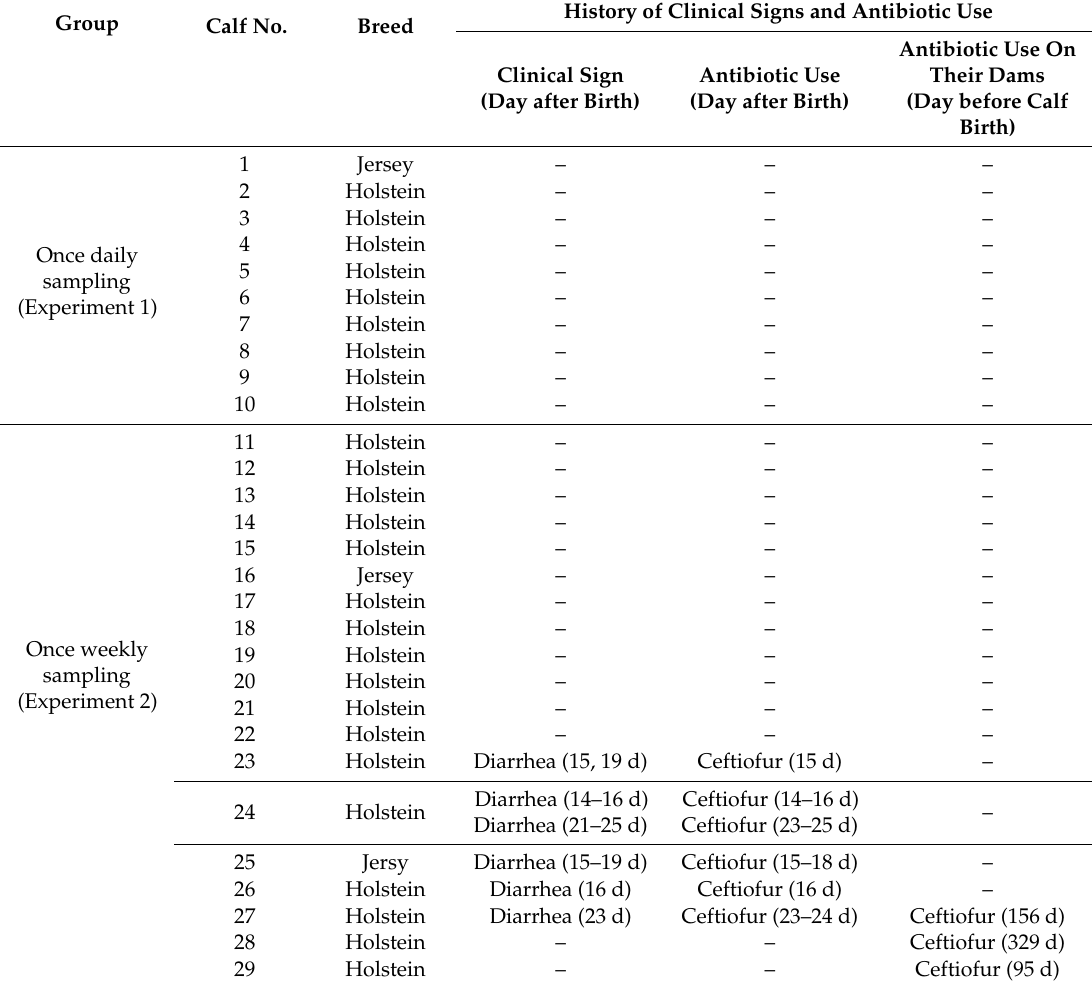
Table 1. Detailed information about 29 newborn calves included in this